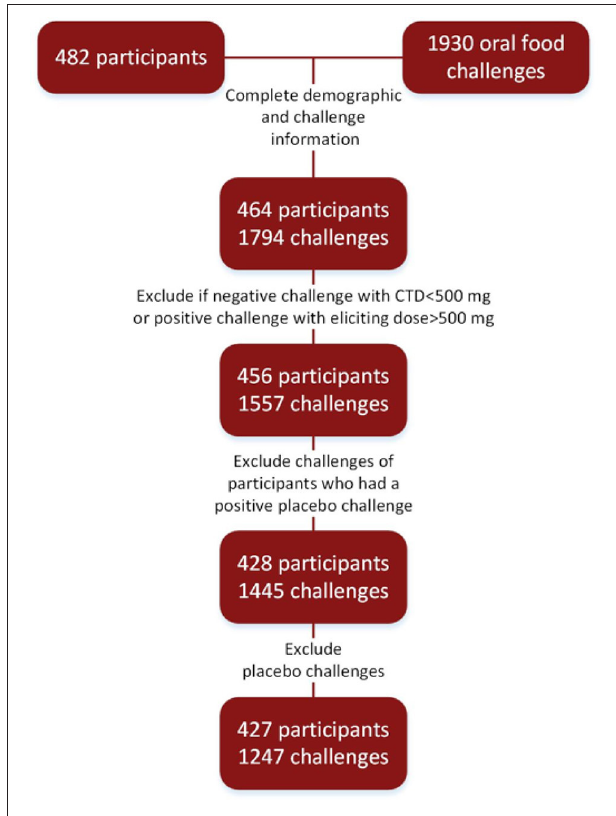
FIGURE 1 | Consort diagram: food challenges conducted in research settings to arrive at final cohort.